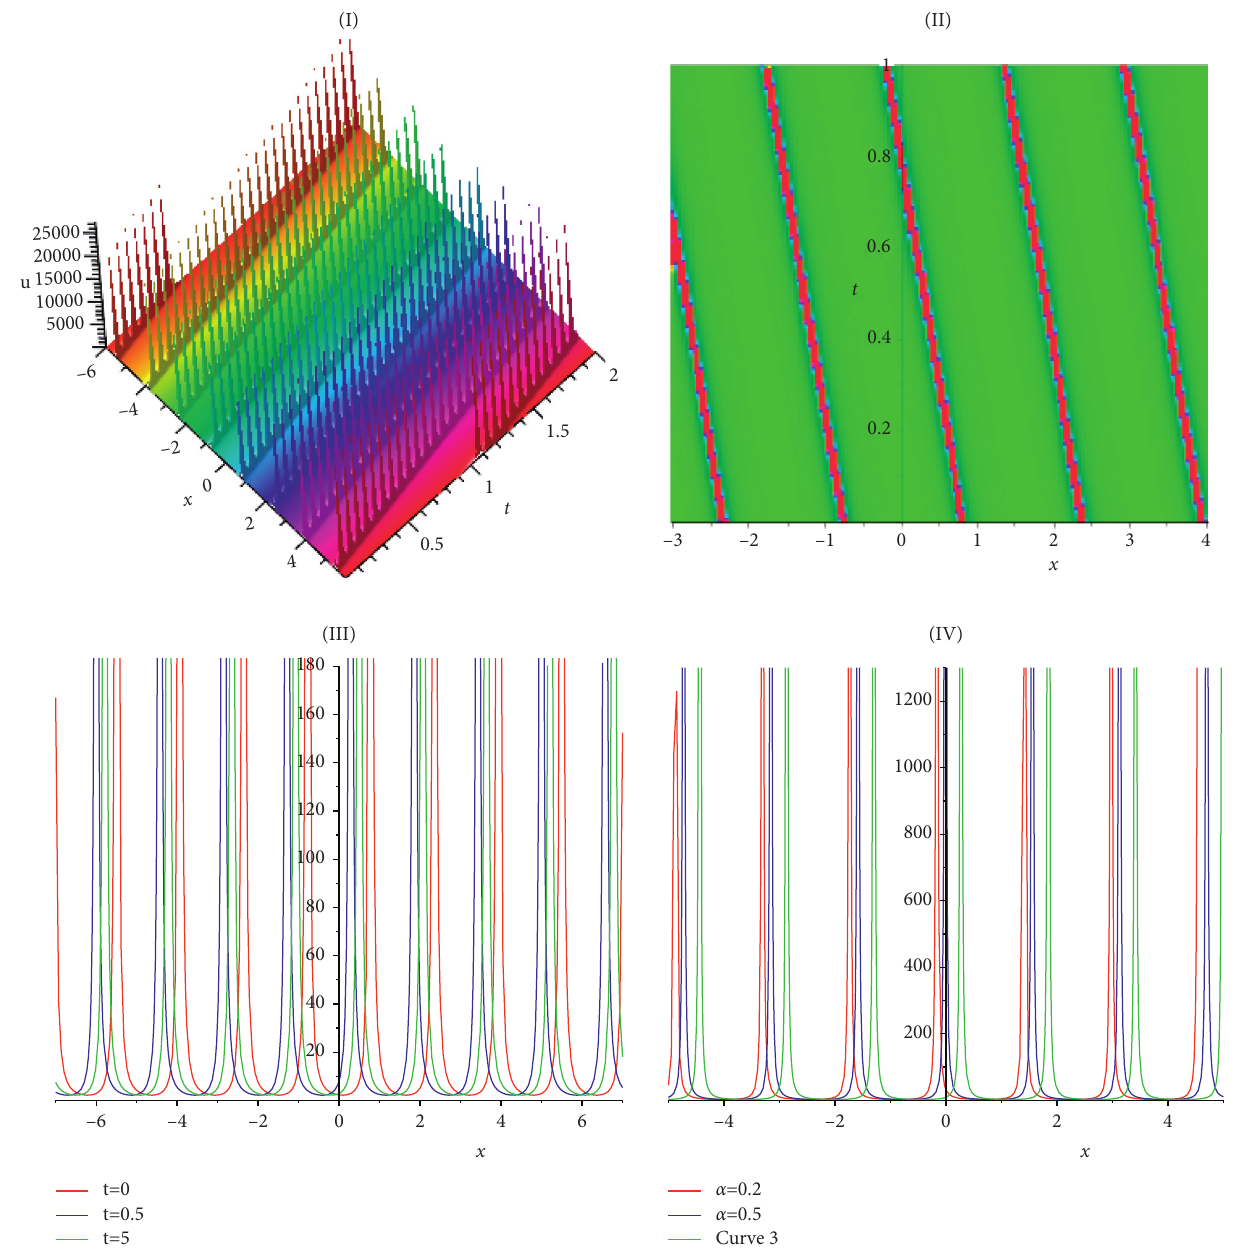
Figure 1: Evolution of the periodic solution (23) with data r � , k